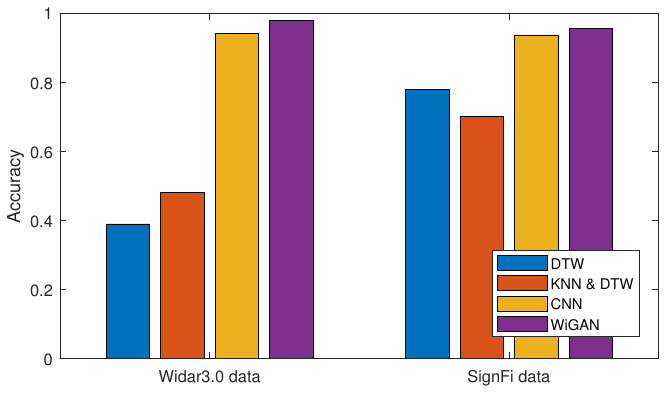
Figure 5. Comparison of recognition accuracy in different